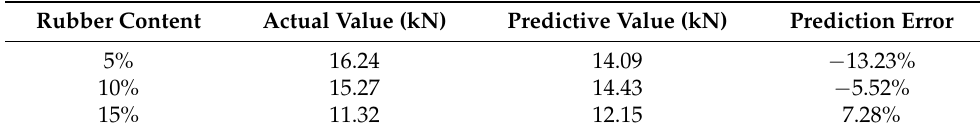
Table 5. Ringing count (2) single-parameter neural network prediction results.